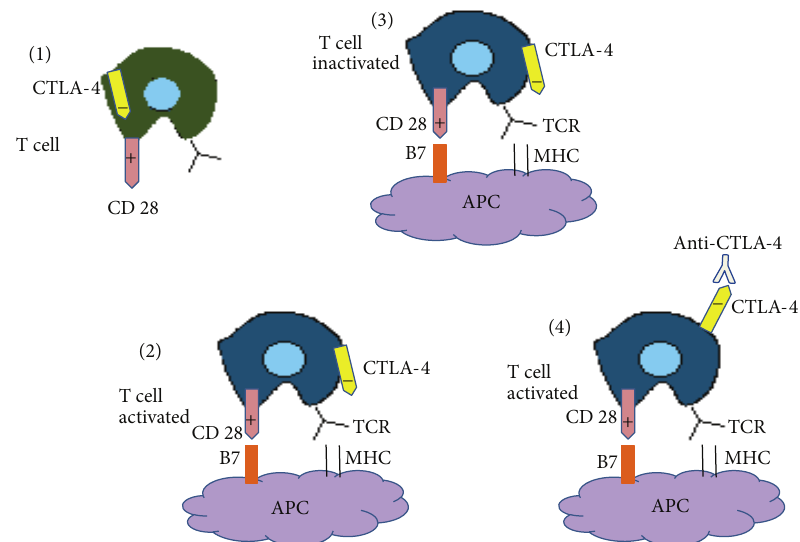
Figure 1: Role of CTLA-4 in T-cell activation. (1) CTLA-4 is a negative regulator of T-cell activation. (2) Conventional T cells are activated by engagementofMHCandB7.(3)Uponactivation,T-cellsexpressCTLA-4.BindingofCTLA-4withB7inhibitTcellactivation.(4)Blockadeof CTLA-4 produces the liberation of CD28 that engages with B7 activating T cells. APC: antigen presenting cell; MHC: major histocompatibility complex; and TCR: T-cell